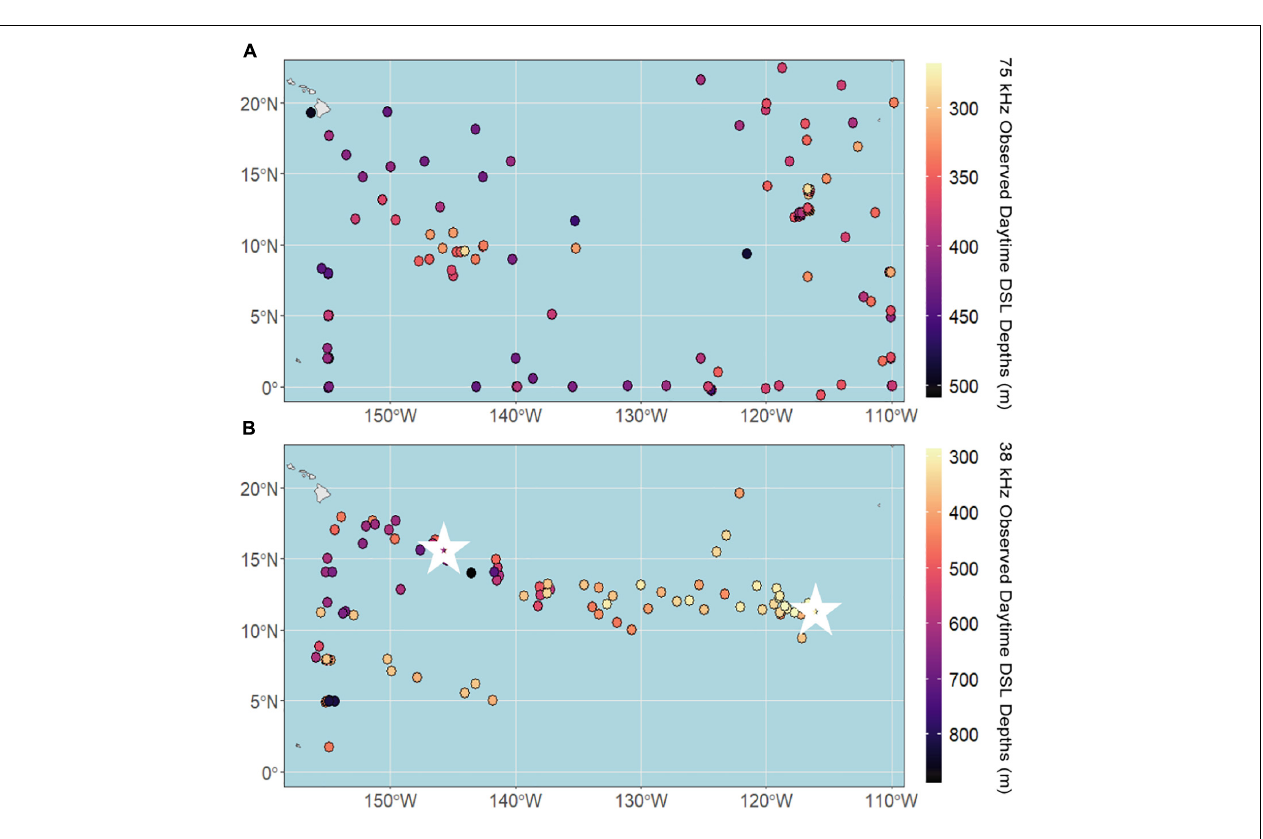
CCZ Model Predictions DSL Depth Model predictions for both frequencies extended our observations of shallow DSL depths in the eastern and central CCZ, largely overlapping the most hypoxic waters of the